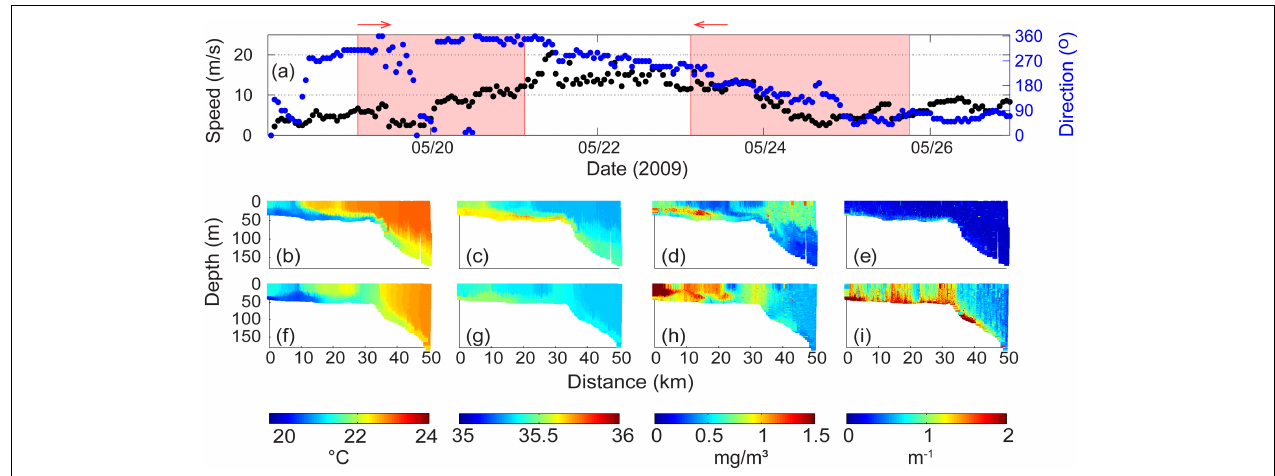
FIGURE 7 | (a) Wind velocity and direction at Rottnest Island during 19–25 May 2009. The shaded areas represent the period of ocean glider transect; Ocean glider vertical cross-sections of (b) temperature ( ◦ C); (c) salinity; (d) chlorophyll (mg m − 3 ); and, (e) backscatter (m − 1 ) across the Rottnest continental shelf during 19–21 May 2009; (f–i) water properties during 23–25 May 2009. The glider flight direction is indicated by the